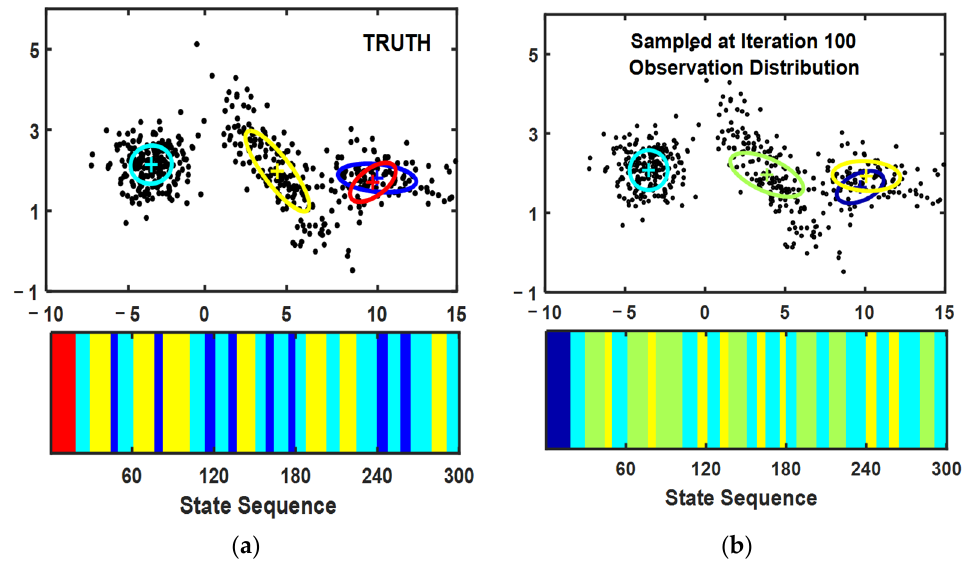
Figure 6. ( a ) Observed “true” state sequences corresponding to the simulated WDC evolution trend in Figure 2. The scatter plot shows observed data; ( b ) the observation distribution scatter plot, and the estimated states sampled at the 100th iteration.